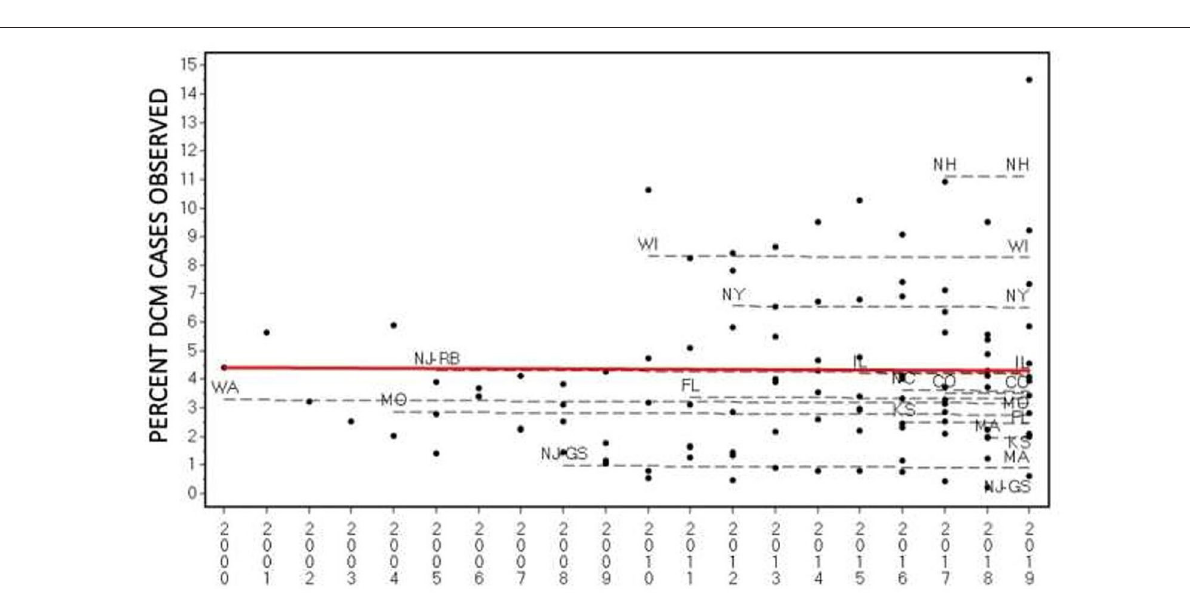
FIGURE 2 | Mixed model random coefficient regression analysis including all services except for Ethos-Hawaii (only one data point). Black points indicate percent dilated cardiomyopathy (DCM) per service each year. Trend-lines for each service are shown as black dashed lines. The best-fitted regression model is shown in red. NH, Ethos New Hampshire; WI, Ethos Wisconsin; NY, The Heart Vet; NJ-RB, Red Bank New Jersey; IL, Ethos Illinois; WA, Washington State; NC, Veterinary Specialty Hospital North Carolina; CO, Ethos Colorado; FL, Southwest Florida Veterinary Specialists; MO, University of Missouri; KS, Kansas State University; MA, Ethos Massachusetts; NJ-GS, Garden State New